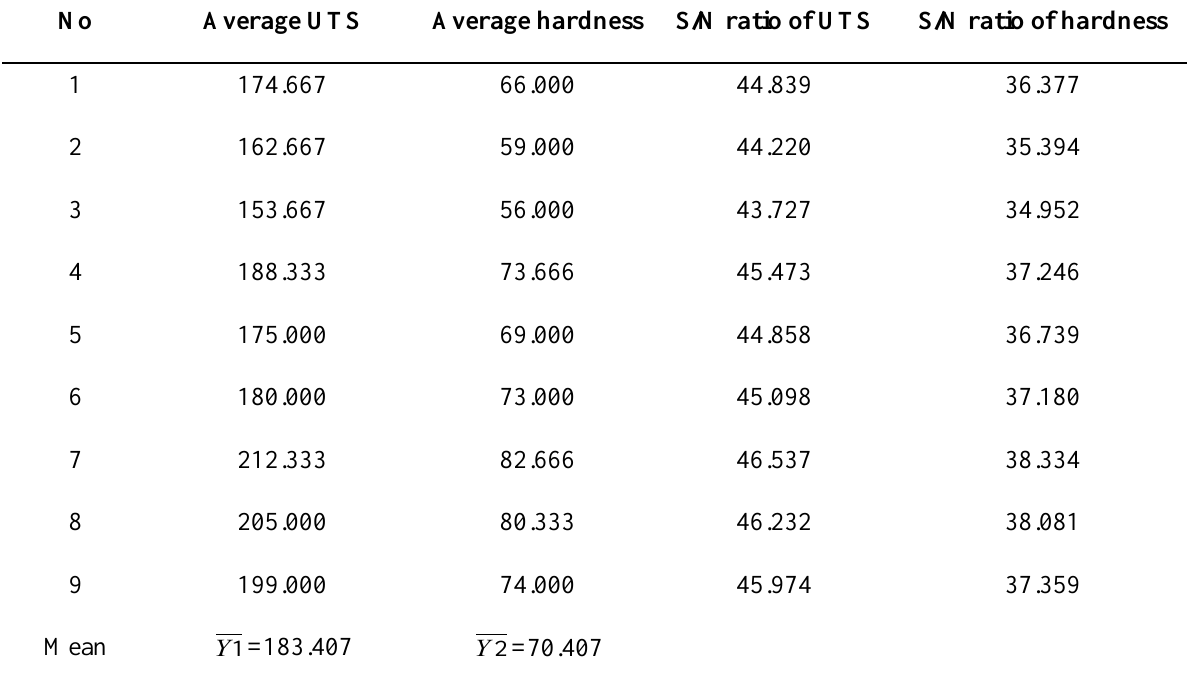
Table 6. Computation of S/N ratio for ultimate tensile strength (UTS) and